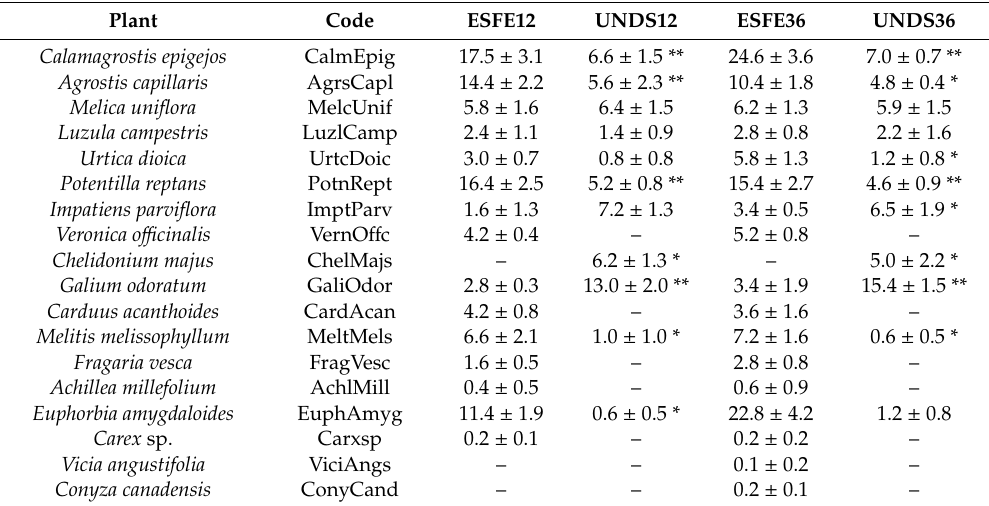
Table 1. Means of main understory plants cover (%) associated with associated with early-successional forest ecosystem (ESFE) and windstorm undisturbed areas (UNDS) 12 and 36 months after event each data is an average of the individual plots and sampling date (mean ±